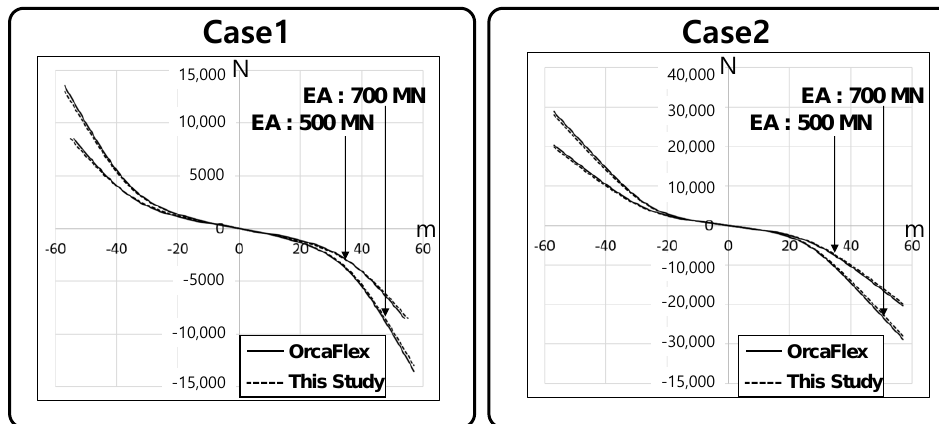
Figure 13. Restoring force for examples of pulling tests.